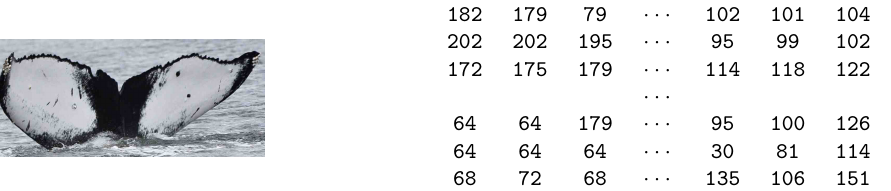
Figure 2. Whale tail image vector. Left image is the picture taken and right one is the coded image